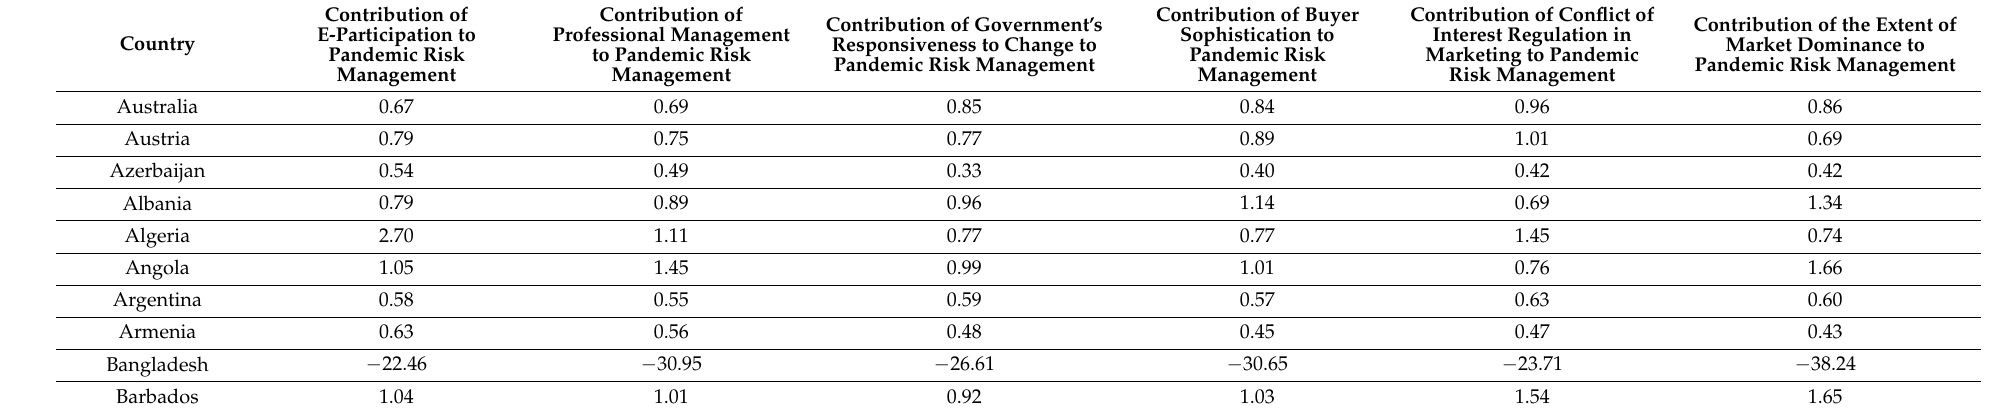
Table A4. Contribution of individual management and marketing factors to the pandemic risk management in the second trimester of